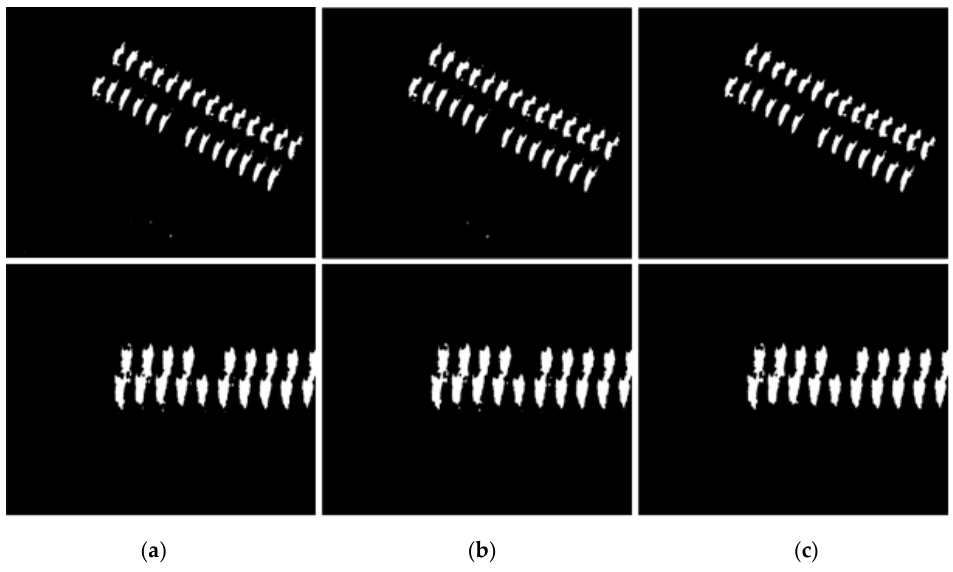
Figure 3. Pseudo objects removing process: ( a ) Morphological processing; ( b ) Median filter; ( c ) Pseudo objects removal.